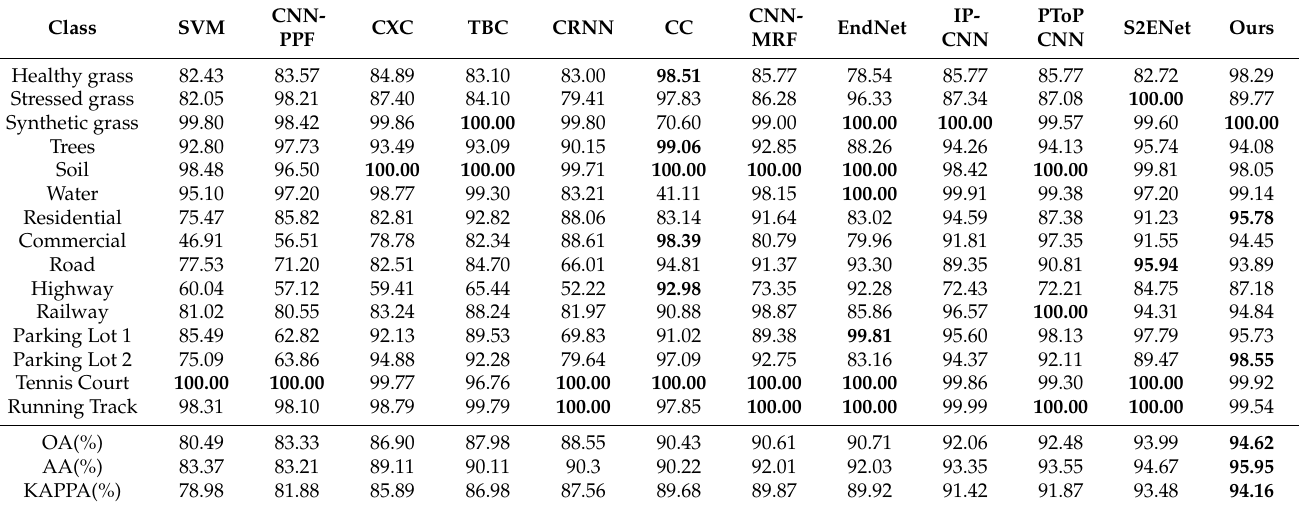
Table 1. Comparative experiment of the Houston